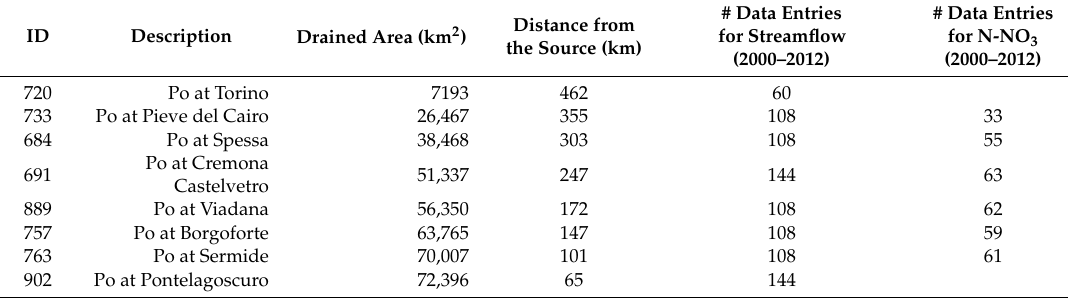
Table 3. Characterization of monitoring stations along the Po River (# is the number of data